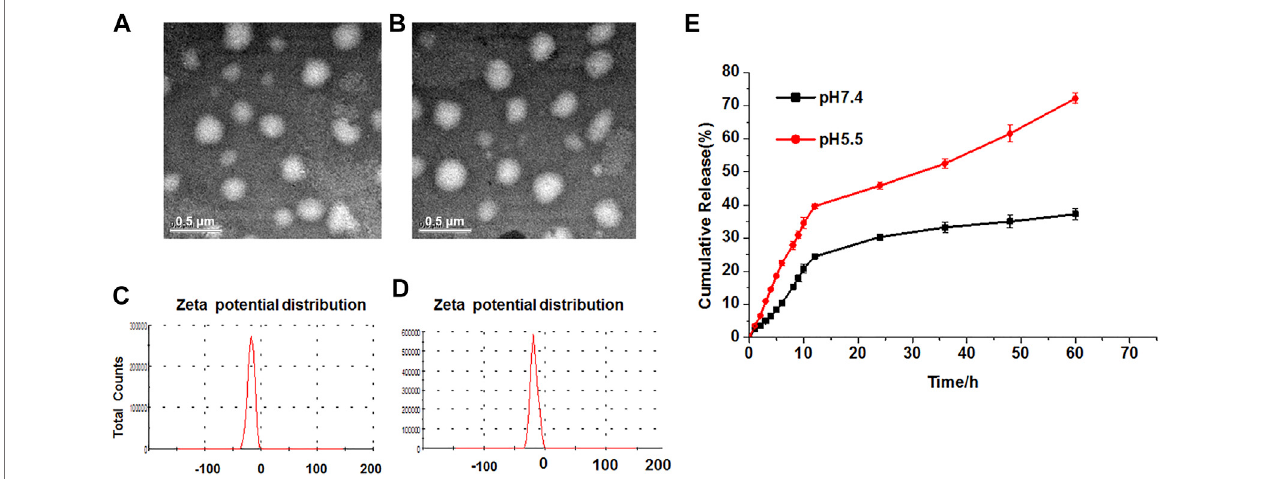
FIGURE 1 | Characterization and in vitro drug release of TPGS-Res-SLNs. TEM image (scale bar: 500 nm) of (A) Res-SLNs and (B) TPGS-Res-SLNs in the suspension. The Zeta potentials of (C) Res-SLNs and (D) TPGS-Res-SLNs. (E) In vitro release pro fi les of Resveratrol from TPGS-Res-SLNs at different pH (pH 7.4 and pH 5.5). Data are expressed as the mean ± S.D. ( n (cid:1)